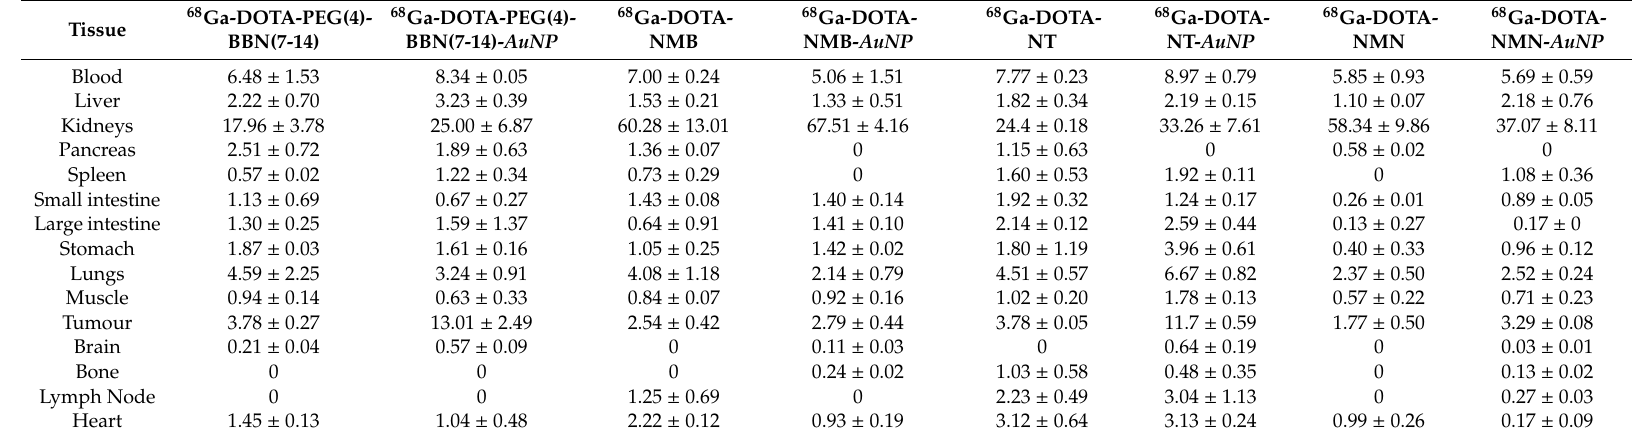
Table A2. Ex vivo biodistribution data on NU / J mice inoculated with DU-145 prostate cancer